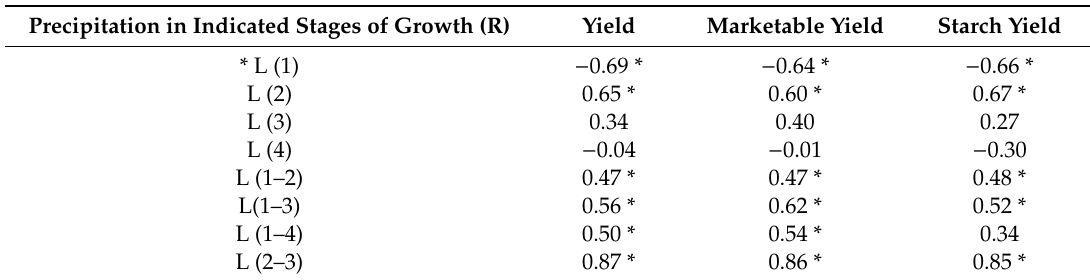
Table 5. Spearman correlation coe ffi cients between yield elements and the number of days with precipitation in various stages of potato development.